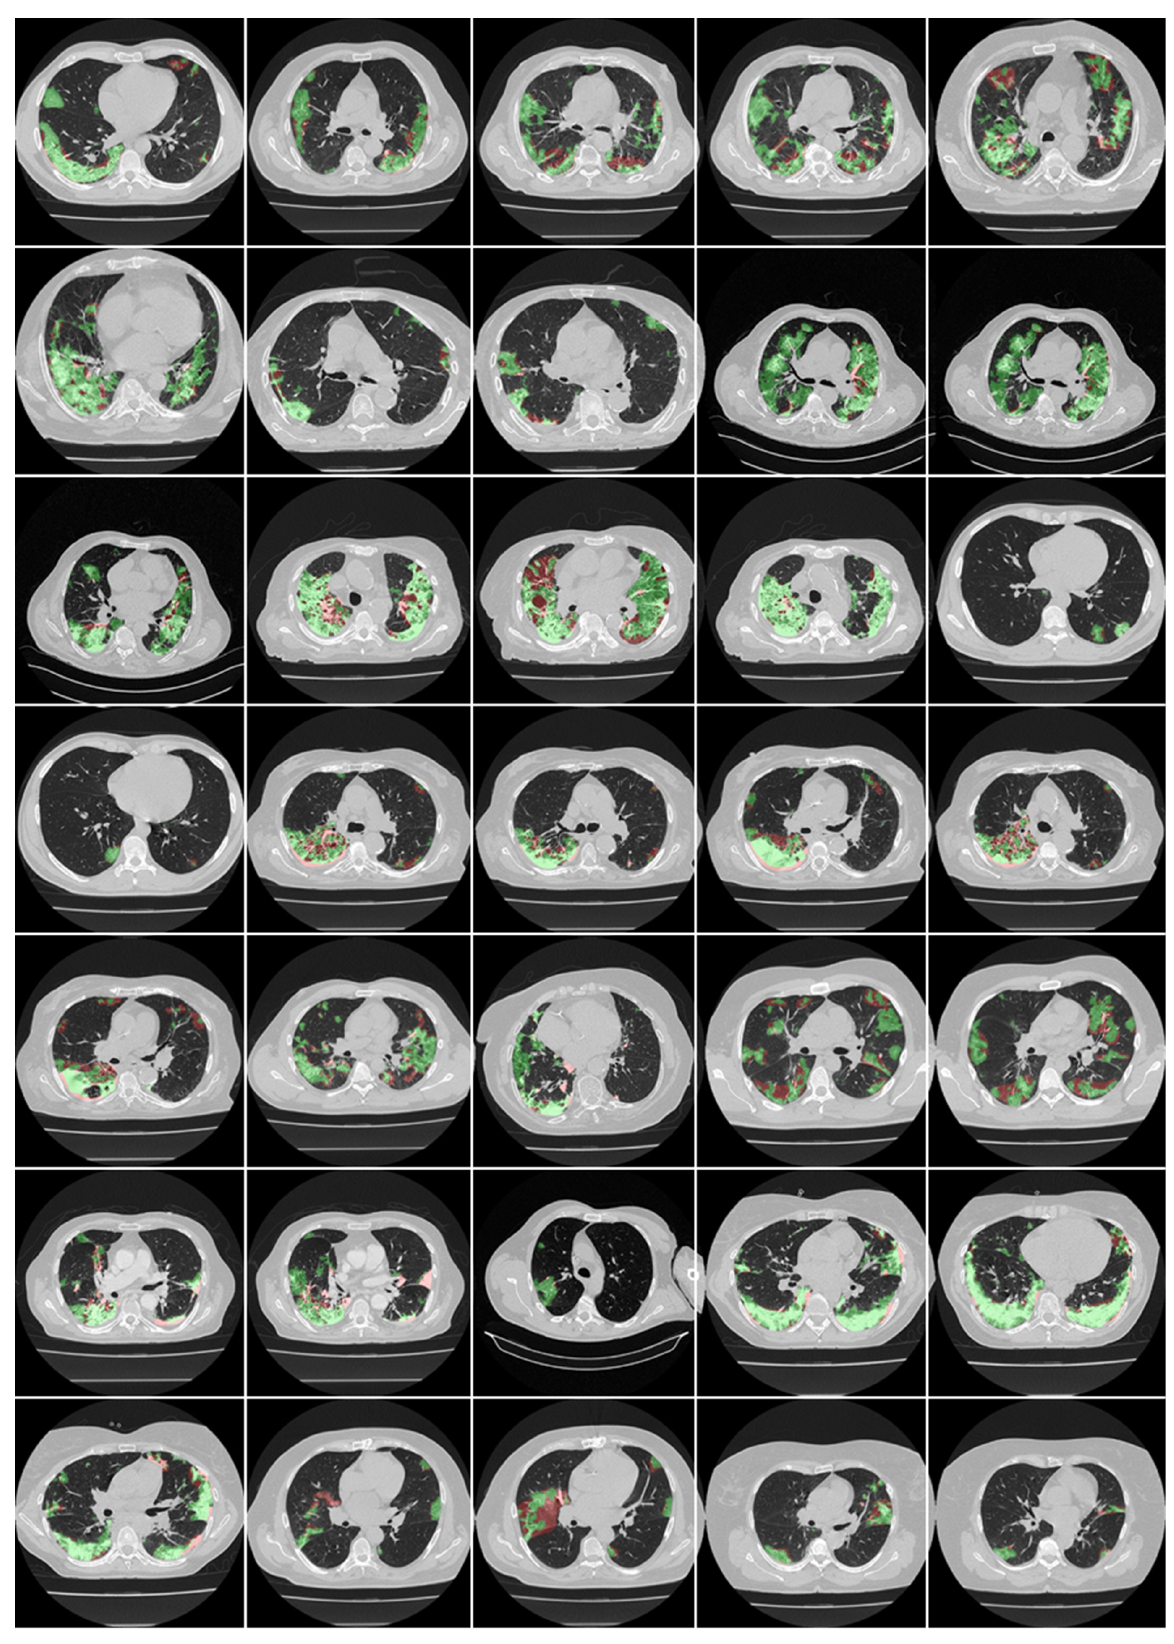
Figure A6. Results of visual lesion overlays showing MedSeg (green) vs. MD 1 (red).